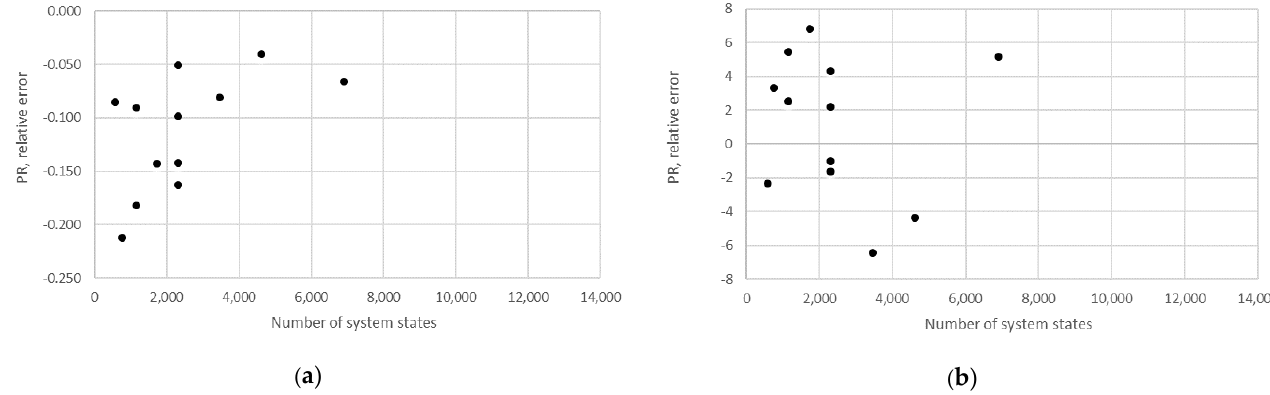
Figure 28. M = 9, relative error obtained using the numerical method—( a ) PR and ( b ) WIP.